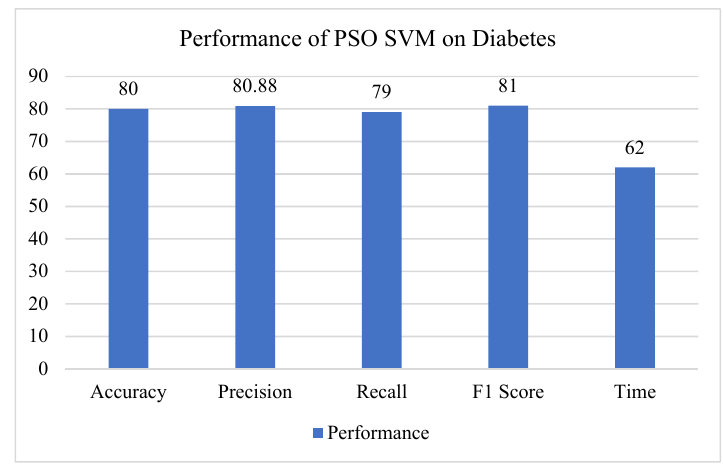
Figure 17. Performance of PSO ‐ SVM on Diabetes.